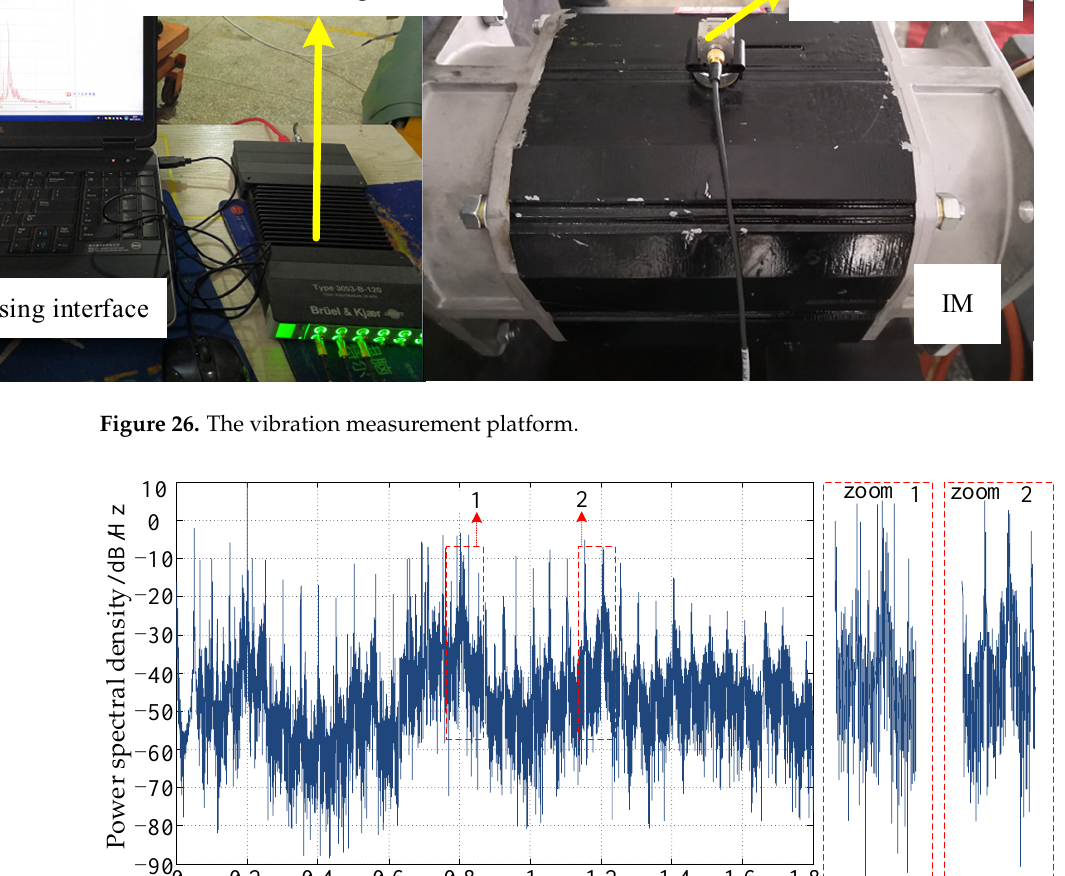
Figure 27. The power spectral density of vibration in IM without compensation.